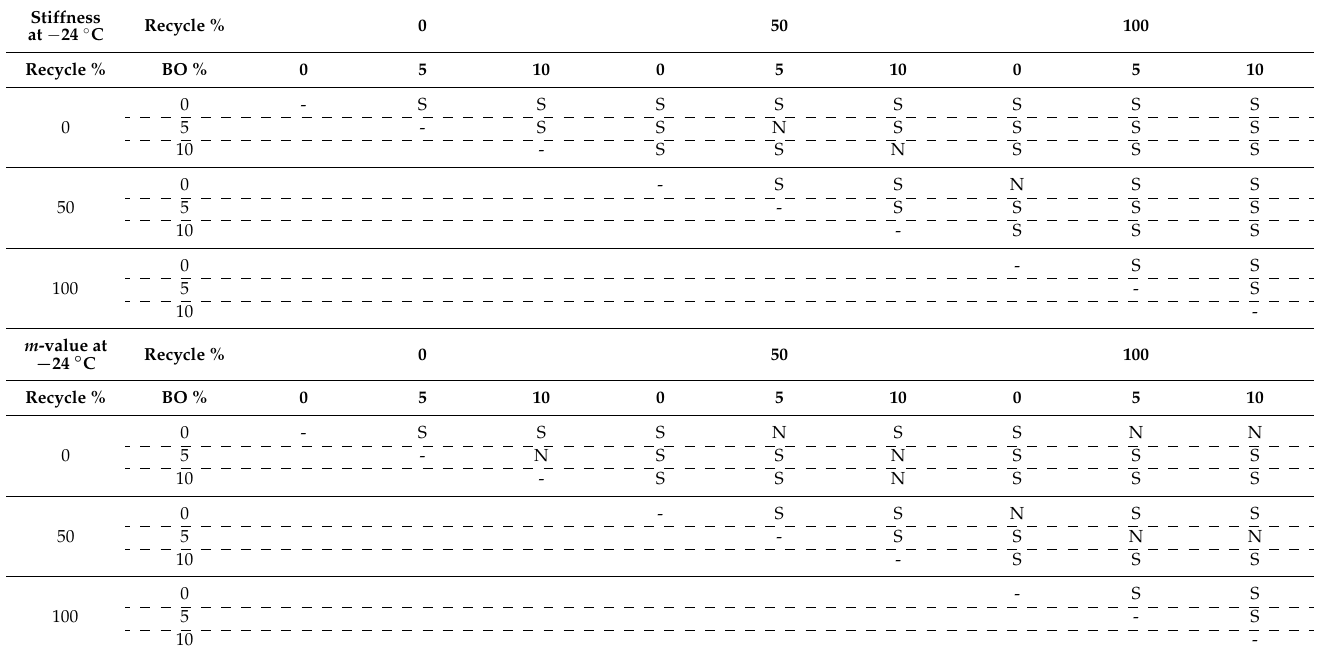
Table 9. Statistical analysis results of the stiffness and m- value for RTFO + PAV as a function of aged binder contents and the addition of base oil at − 24 ◦ C ( α =